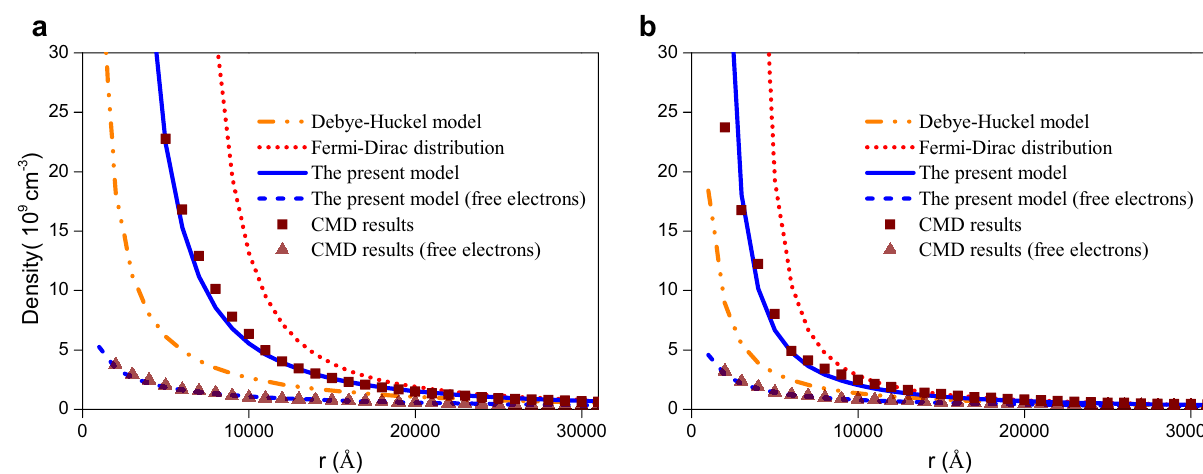
Fig. 5 Electron density fl uctuations of ion embedded in ultra-cold neutral plasmas (UNP). a, b The electron density fl uctuation δρ r ð Þ around an ion ¼ 10 9 cm (cid:2) 3 and T ¼ 5 : 5K and b ρ ¼ 10 9 cm (cid:2) 3 and T ¼ 11 : 5K. The distance r ranges from 0 to ( Q = 1, at origin) embedded in the UNPs with a ρ e e e e a = 2 (cid:5) 31 ; 000 Å. The classical molecular dynamic (CMD) simulated densities of electrons and free electrons are shown in square and triangle, WS respectively. Electron densities from Fermi – Dirac distribution (dash line), linear Debye – Hückel model (dash – dot – dot line), and the present model (solid line) are shown to check their reliabilities. And the free-electron density from the present model is shown in a short dash